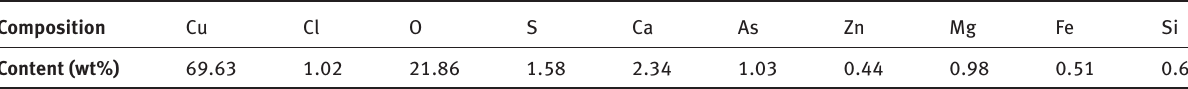
Table 4: The chemical composition of CuCl residue after dechlorination Composition Content (wt%)